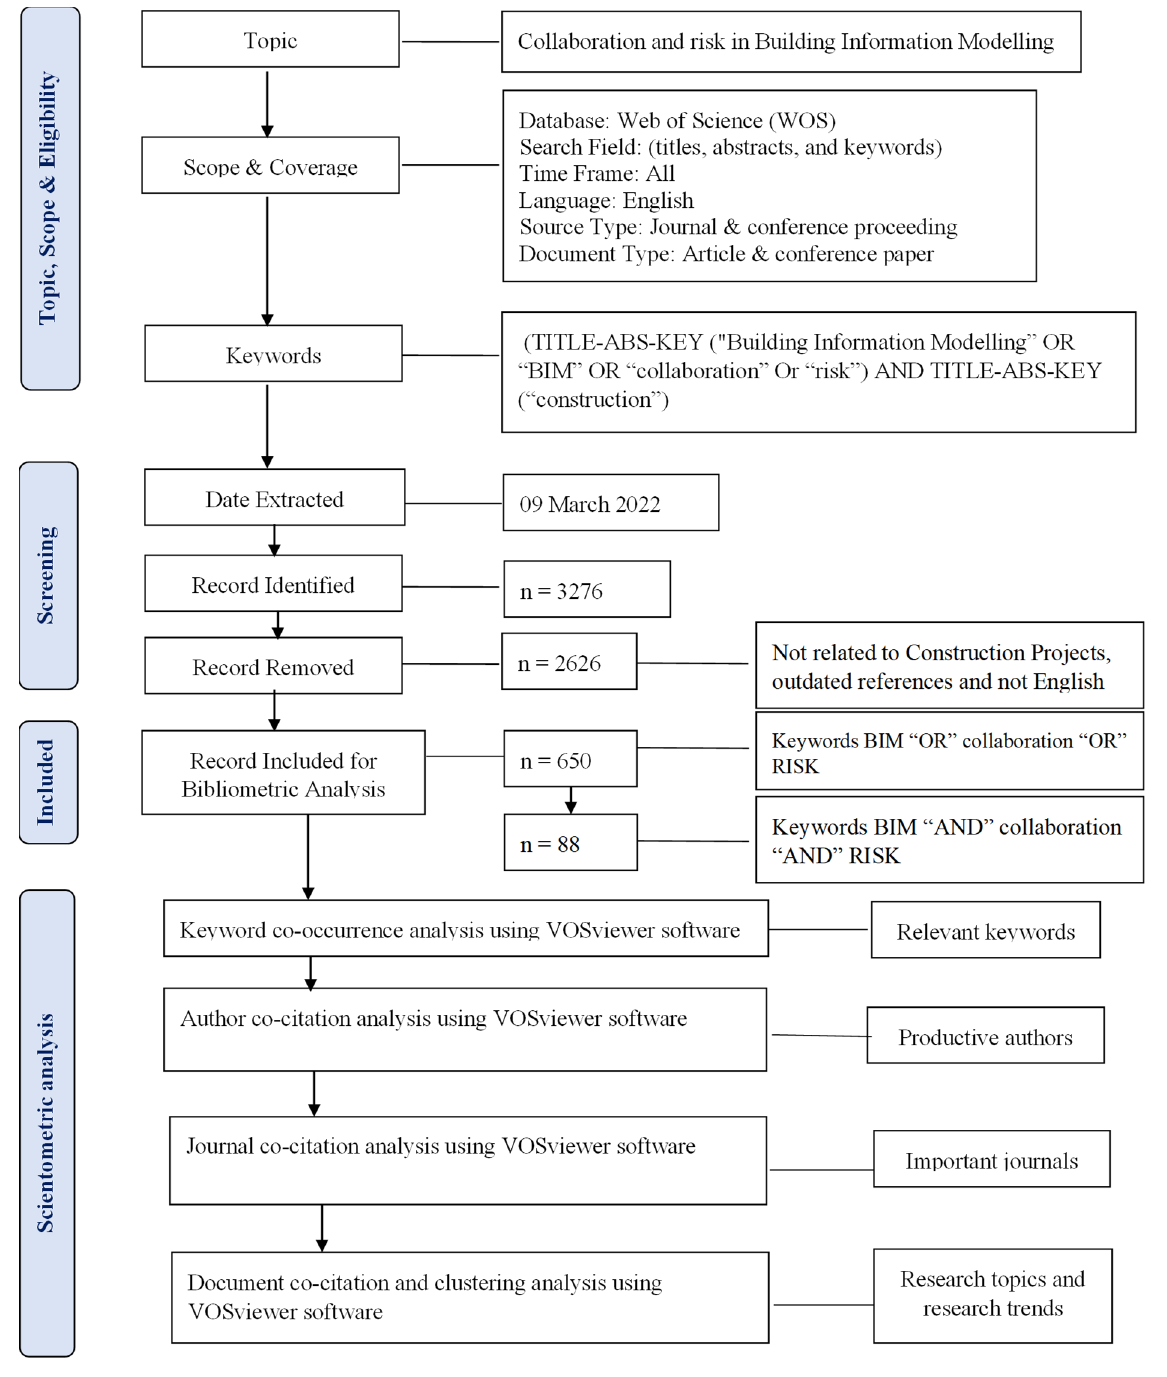
Figure 1. Flow diagram of the search methodology.